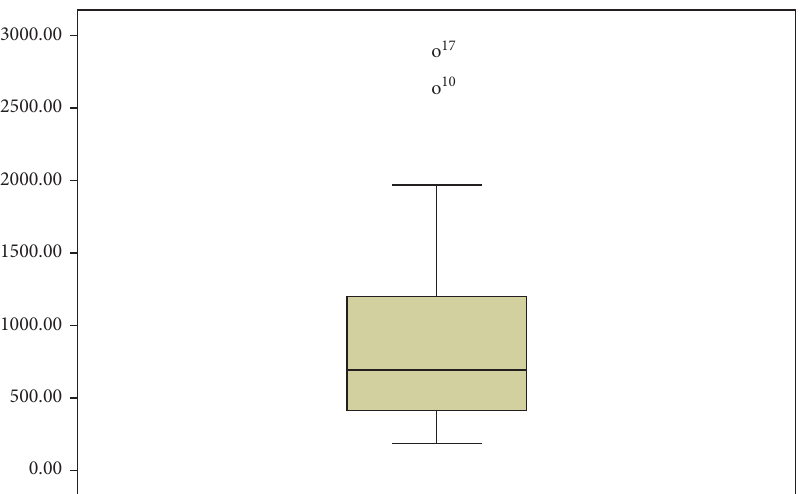
Figure 2: Daily maximum current (box